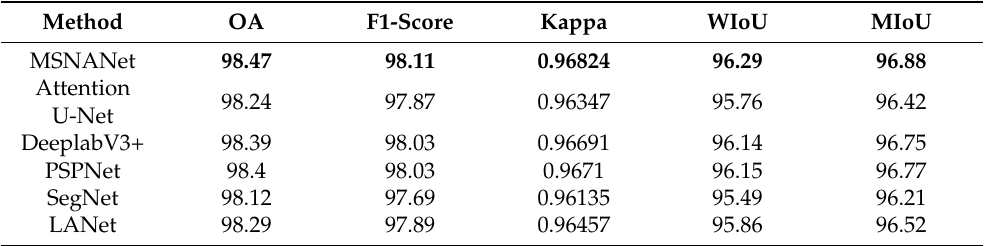
Table 4. Quantitative comparison for the QTPL dataset. Bold numbers indicate the best